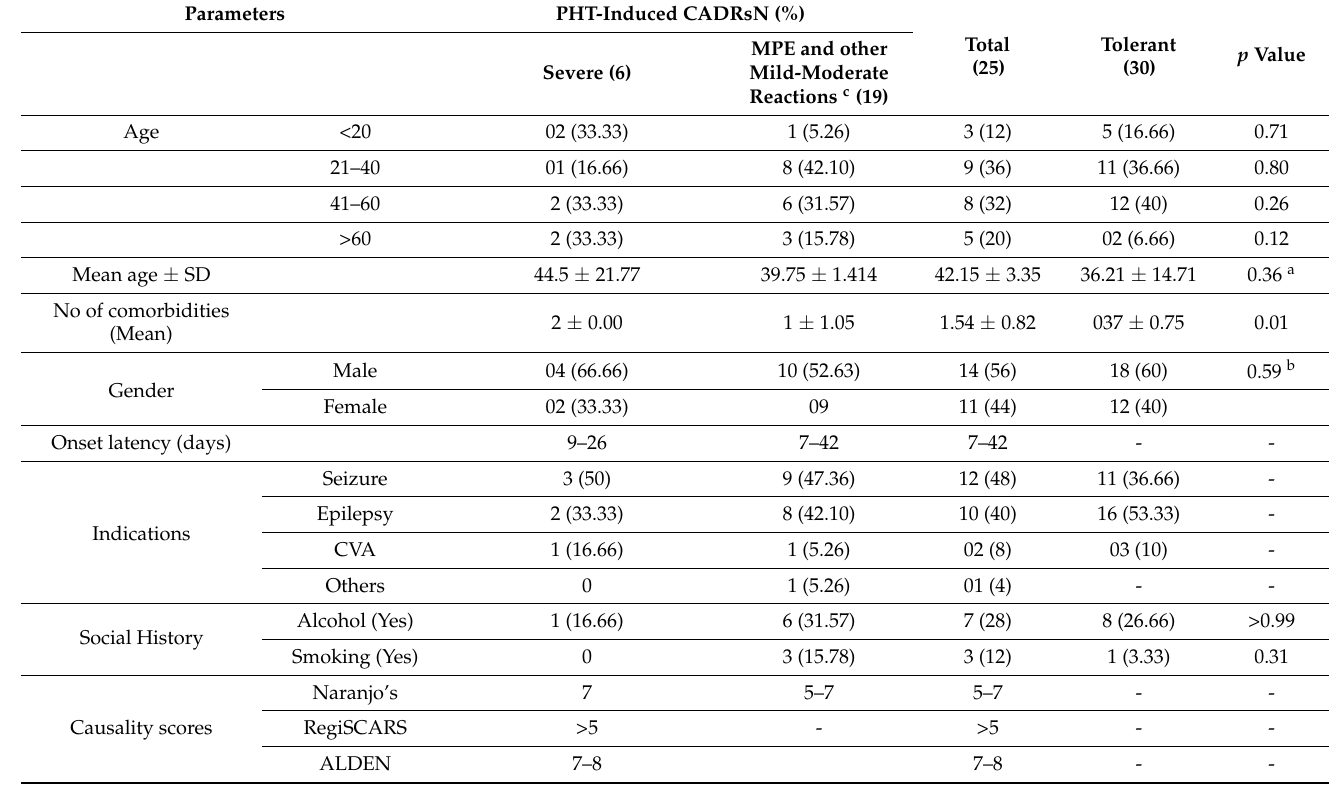
Table 1. Patient demographics and clinical manifestations of PHT-CADRs and PHT-tolerant